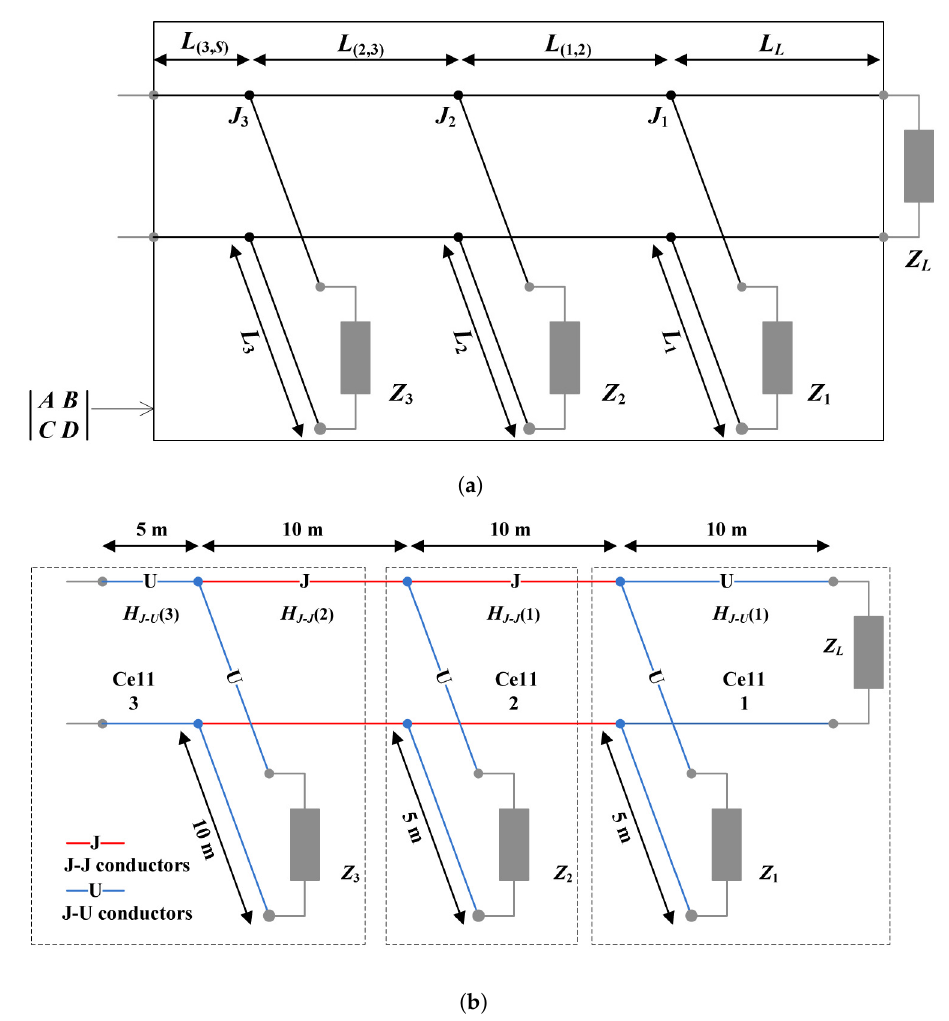
Figure 12. The Cañete wiring topology modeled using ( a ) the ABCD matrix method, and ( b ) the cell division